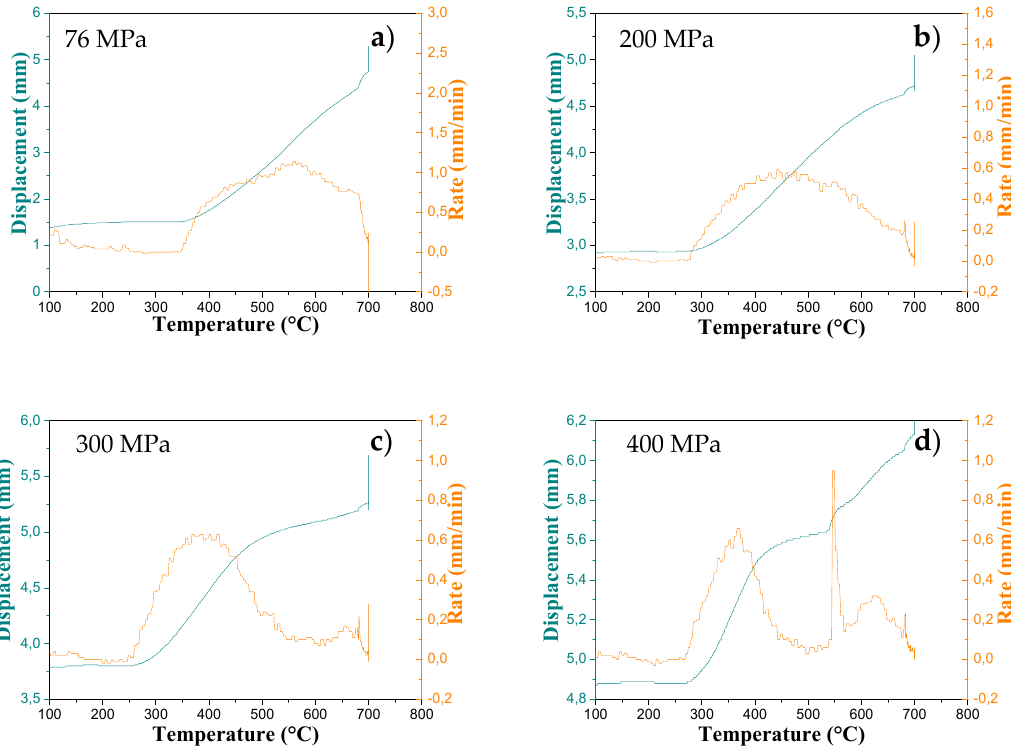
Figure 3. Sintering cycles of TiO 2 :2%Nb nanoparticles (pre-calcined at 500 ◦ C / 4 h) up to 700 ◦ C under different pressures: ( a ) 76, ( b ) 200, ( c ) 300 and ( d ) 400 MPa.